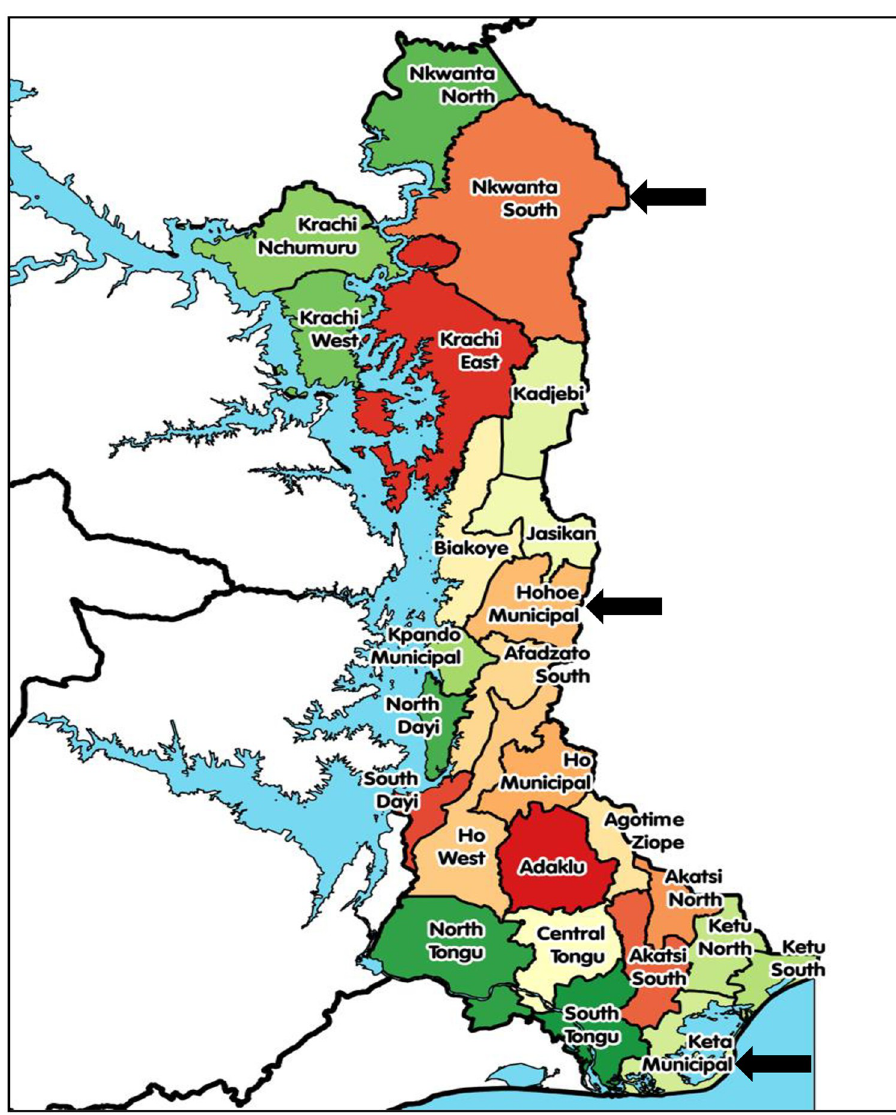
Fig 1. Map showing the three study municipalities/districts in the Volta and Oti